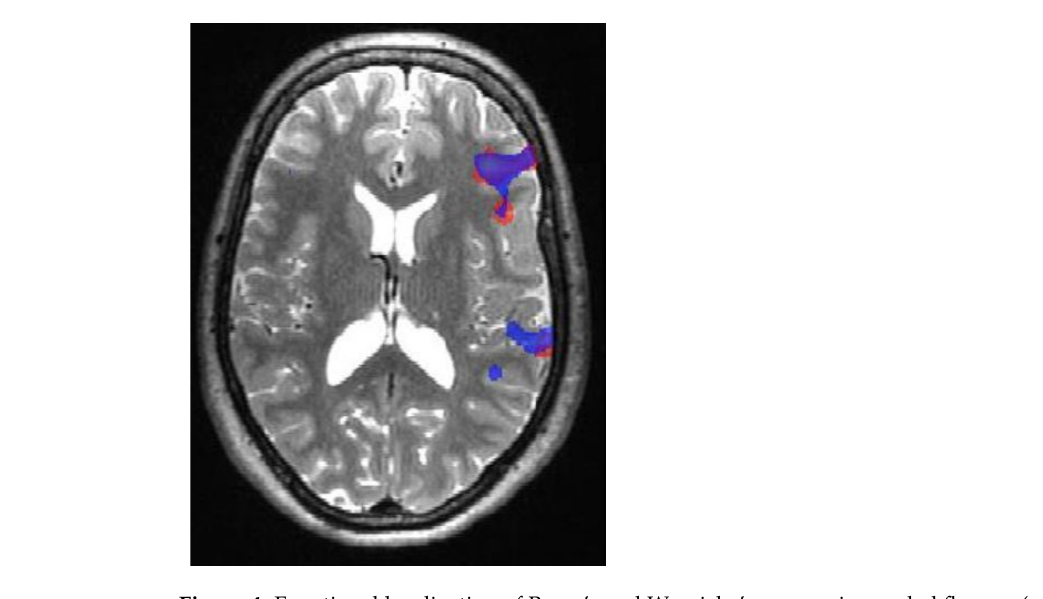
Figure 4. Functional localization of Broca’s and Wernicke’s areas using verbal fluency (red) and verb generation (blue) paradigms in a control patient.